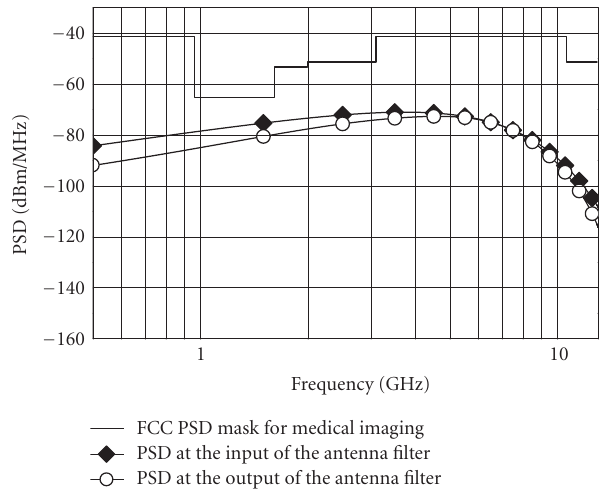
Figure 6: Power spectral density (PSD) of a pulse sequence with PRF equal to 1 MHz versus frequency.